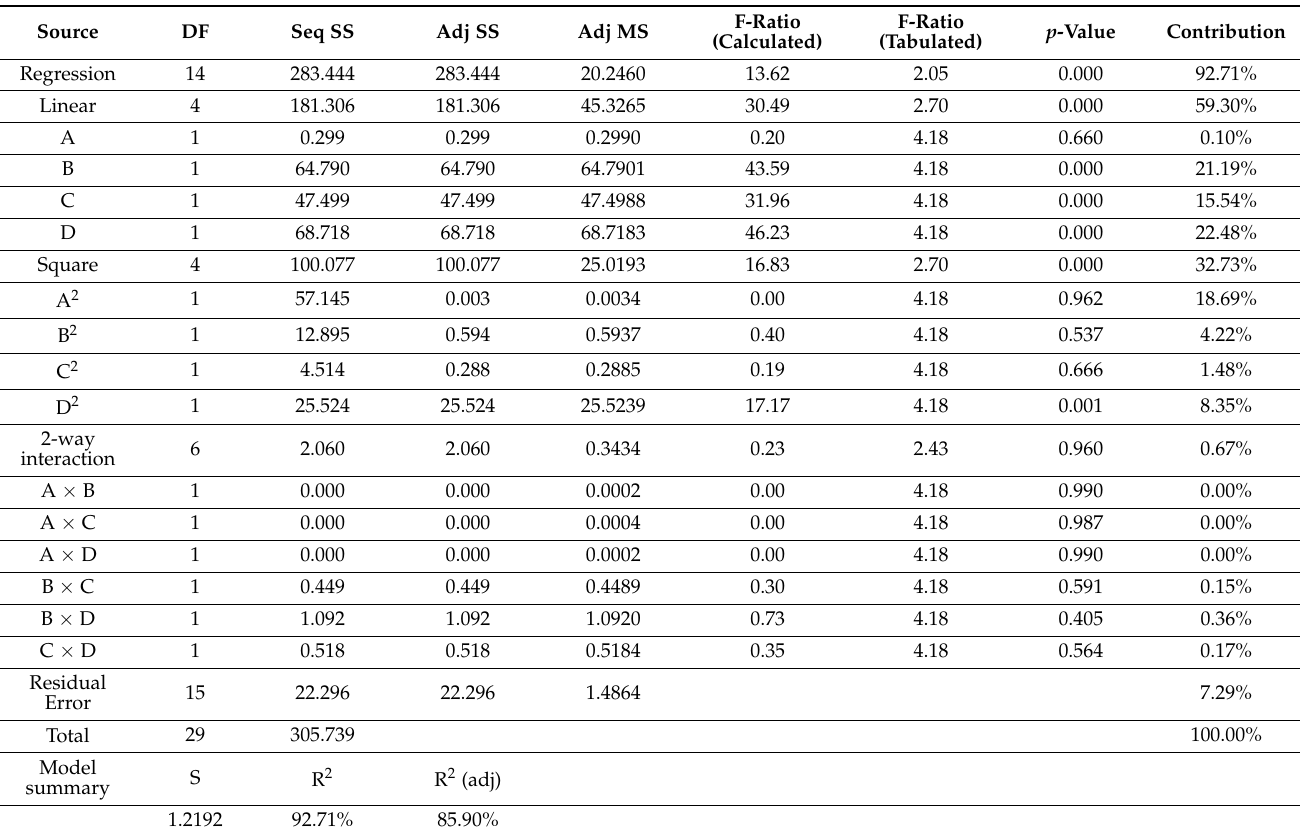
Table 10. ANOVA for thrust force of MoS 2 -loaded